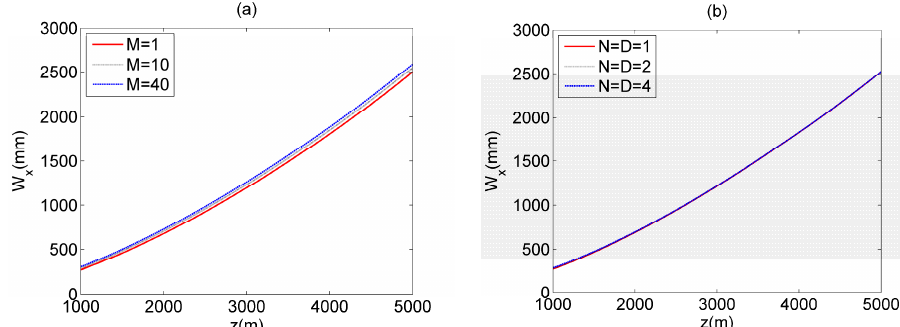
Figure 7. The W x of N × D MGSM array beams propagating through non-Kolmogorov turbulent atmosphere. ( a ) di ff erent M , ( b ) di ff erent N = D .